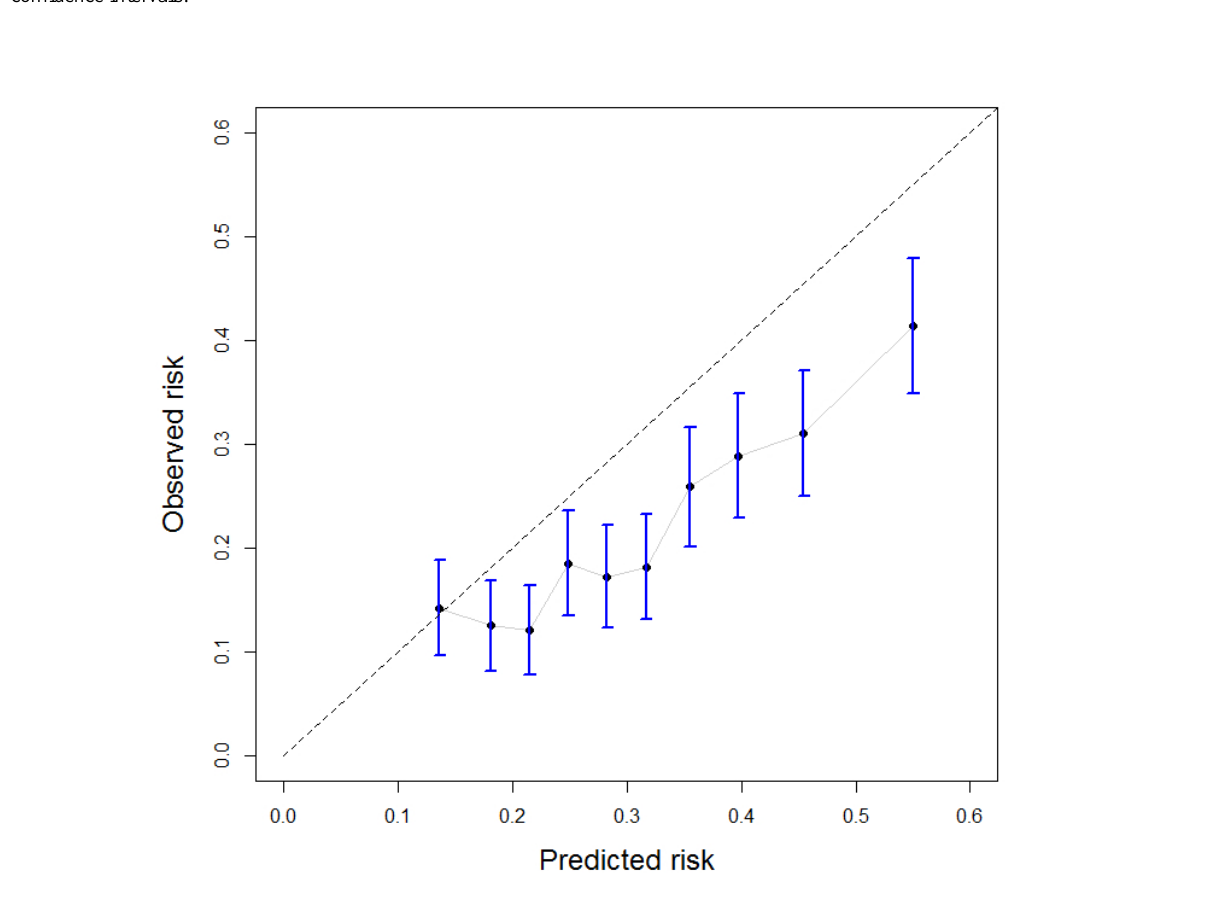
Figure 13. Calibration plot; sample (N=2319) used for validation where divided in 10 deciles, according to their predicted risk. For each decile, the mean predicted risk and the observed proportion of positive cases (proportion of fallers) are shown on the X and Y axes, respectively. Bars indicate 95% confidence